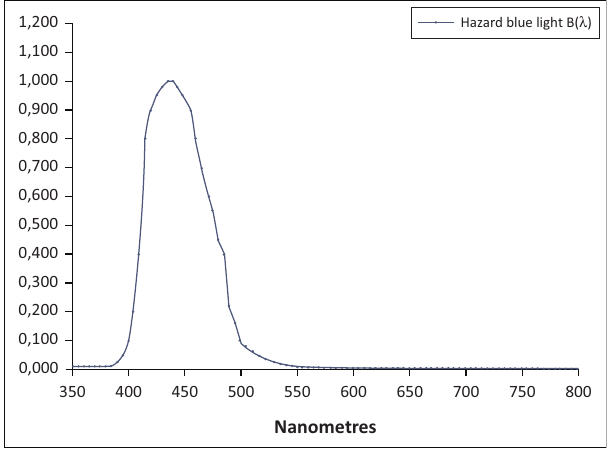
FIGURE 1: The blue-light